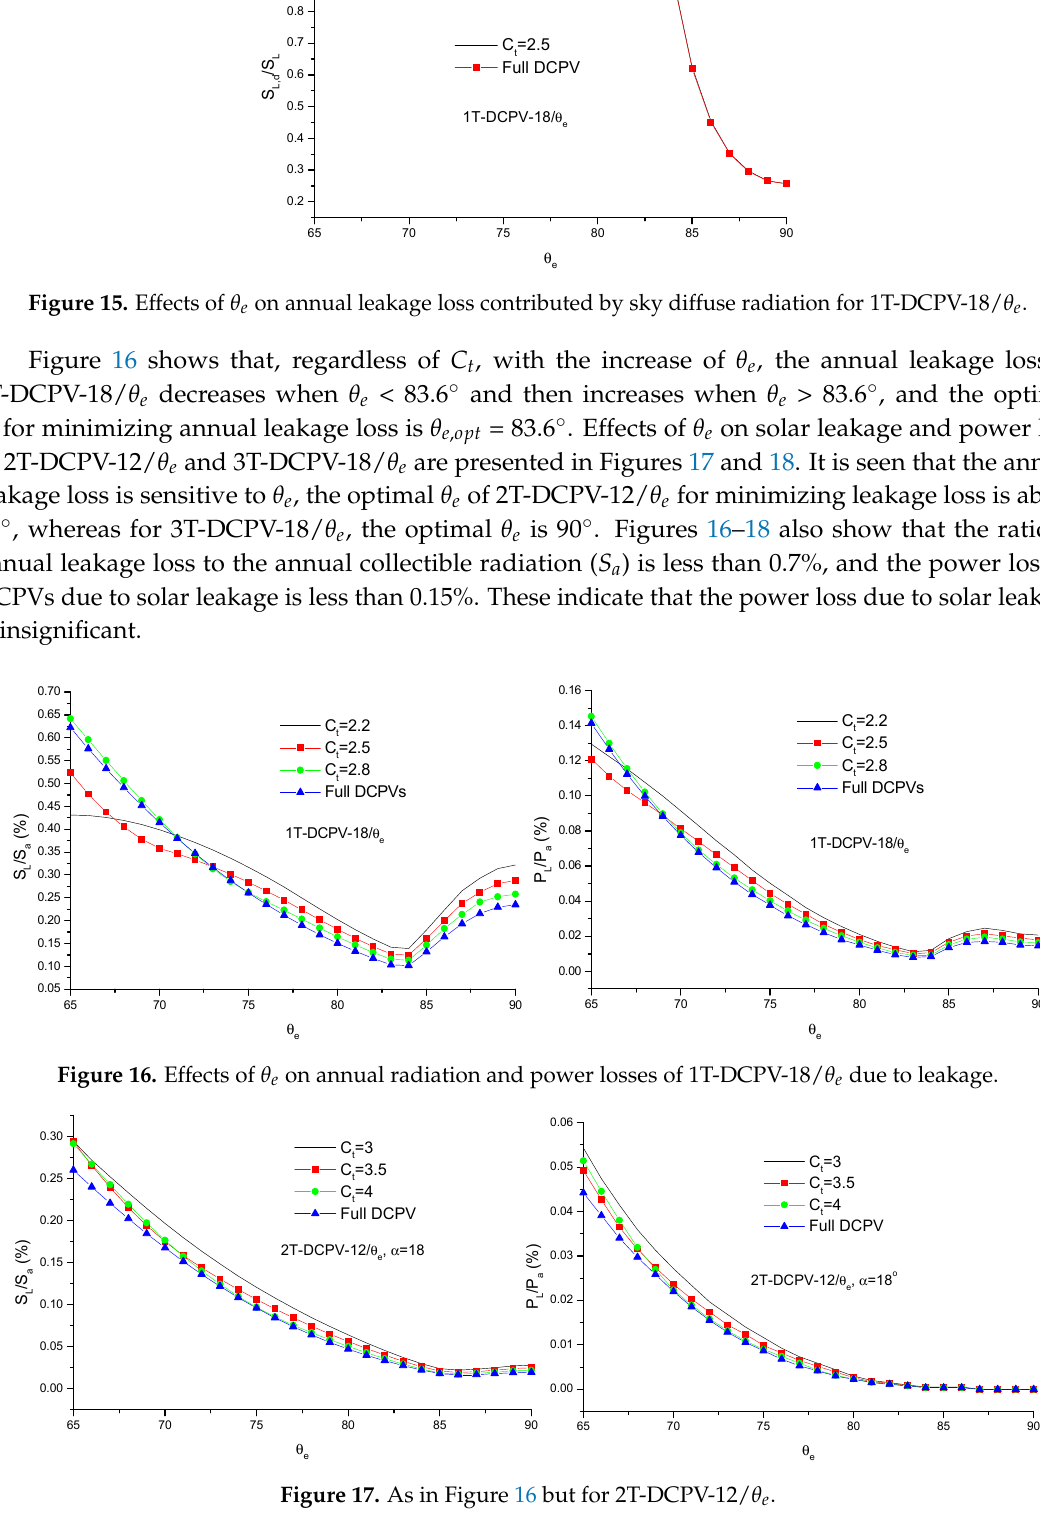
Figure 18 . As in Figure 16 but for 3T-DCPV-18/ e θ . The previous work of the authors [31] indicates that, to make radiation within